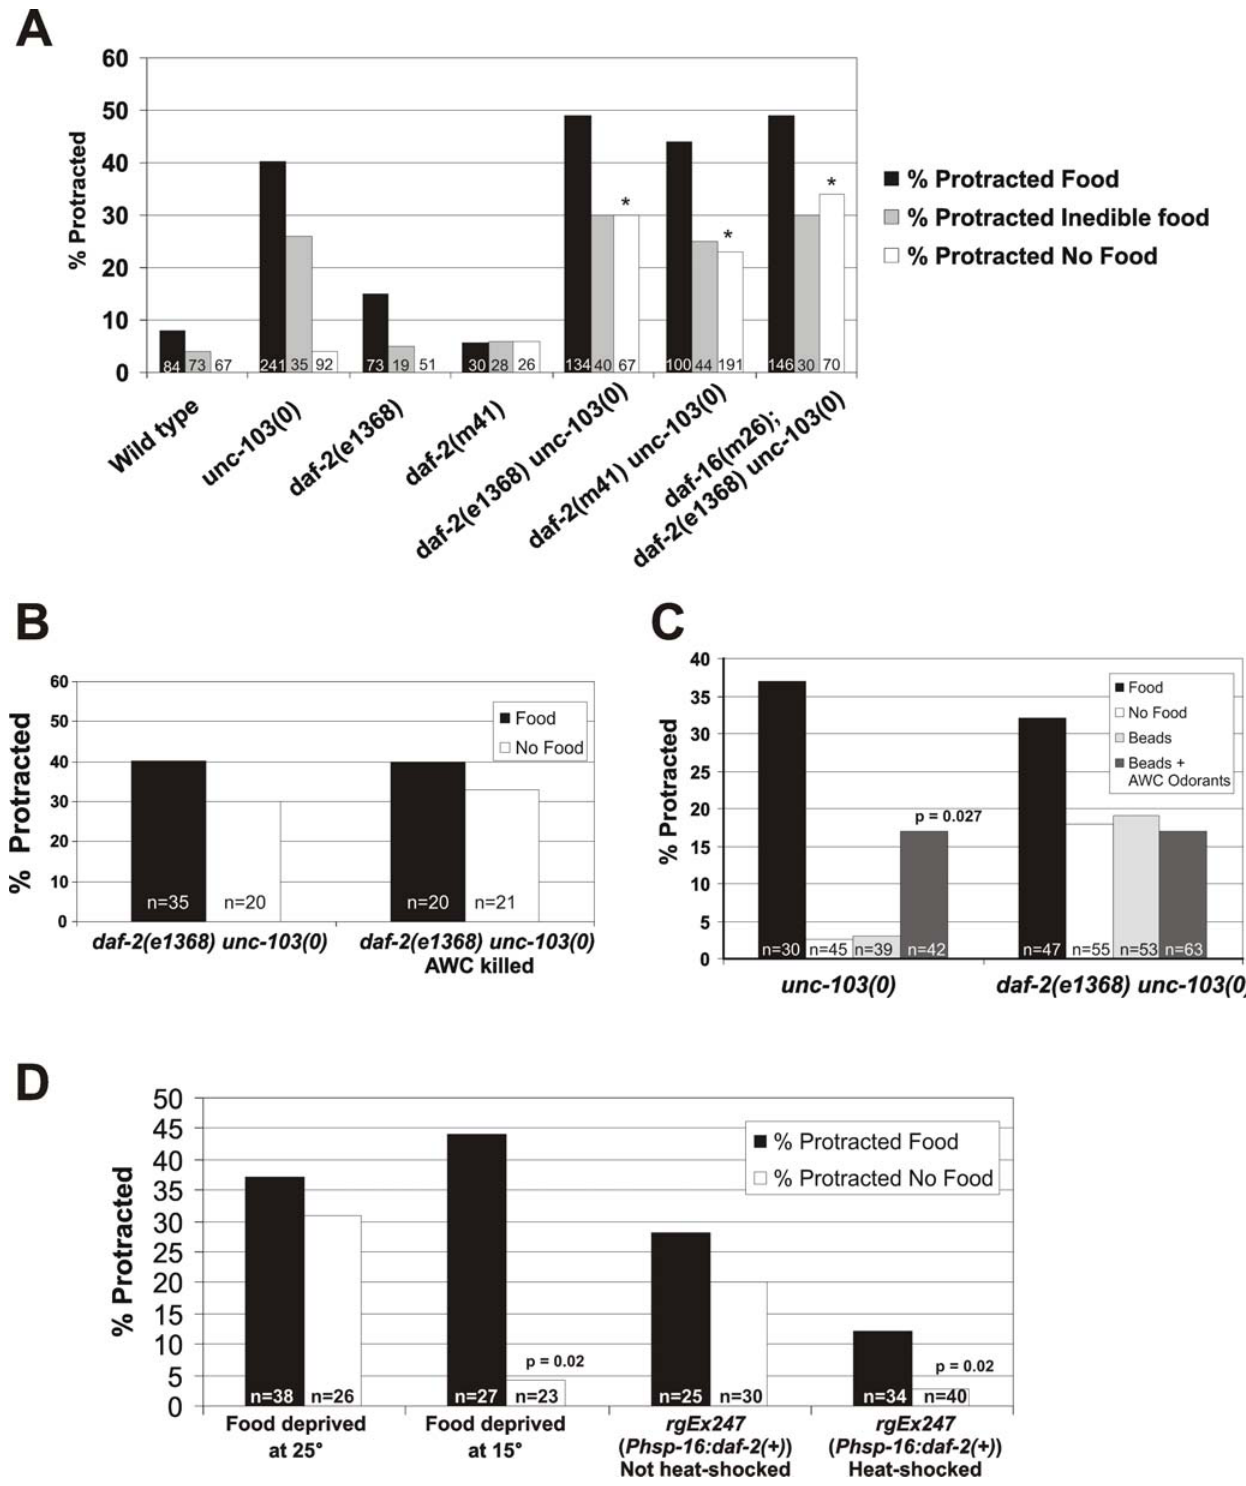
Figure 4. The DAF-2/Insulin-like receptor suppresses sex-muscle excitability under food-deprived conditions. (A) Graph showing the effects of daf-2(lf) mutations on unc-103(0) -seizure susceptibility in food, inedible food, and no food conditions. The * indicates that the p-value is significantly different (p , 0.05) compared to the unc-103(0) control condition (Fisher’s exact test). (B) Graph displaying the effect of ablating the AWC neurons in daf-2(e1368) unc-103(0) mutant males (p-value Fisher’s exact test). (C) Graph displaying the effect of AWC odorants (10 2 4 isoamyl alcohol, 10 2 7 2,3-pentanedione, and 10 2 4 benzaldehyde) on unc-103(0) -induced seizures in unc-103(0) and daf-2(e1368) unc-103(0) males. Sephadex G-50 beads were used as a vehicle for the odorants (p-value Fisher’s exact test). (D) Temperature shift assay and heat-shock rescue for daf-2(e1368ts) unc- 103(0) . Animals were grown at the restrictive temperature (25 u C) and then food-deprived at either the restrictive or permissive temperature (15 u C). For heat-shock rescue, L4 males were heat-shocked for 35 minutes prior to the assay. The p-values listed were calculated using Fisher’s exact test.